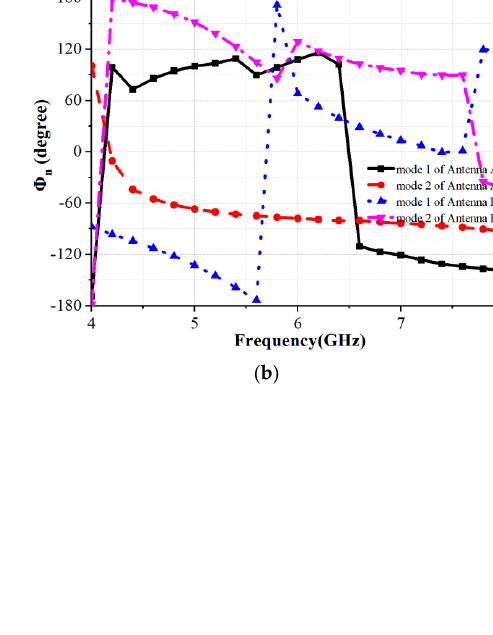
Figure 13. Scattering characteristic mode analysis results of antenna B. ( a ) A n of antenna B; ( b ) φ n of antenna A and antenna B; ( c ) phase difference of antenna A and antenna B.